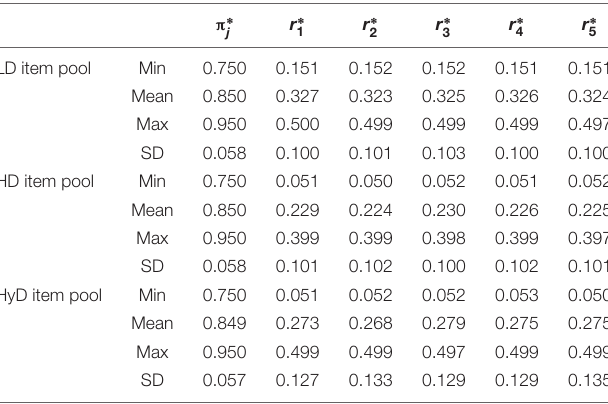
TABLE 1 | Descriptive statistics of item parameters of the LD, HD, and HyD item